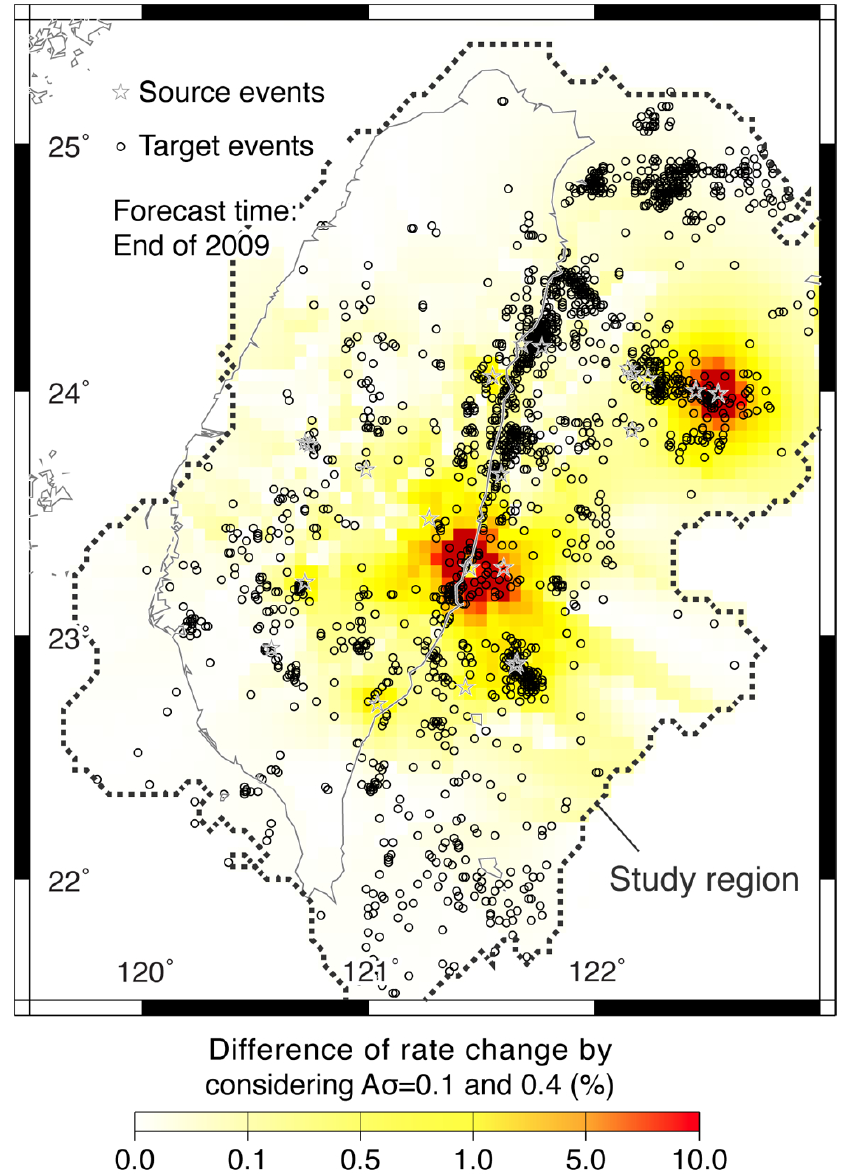
Fig. 8. The difference of the seismicity rate change for different constitutive parameters ( Aσ ) within the rate-and-state friction model. Source events are shown as open stars. Target events are shown as open circles. The source events for calculating the seismicity rate change are shown as stars. As shown in Fig. 2c, the dashed line illustrates the study